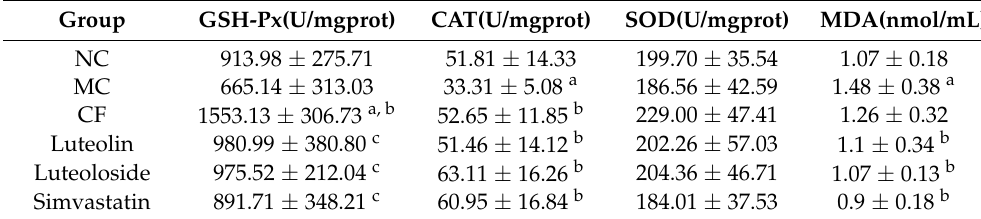
Table 9. GSH-Px, CAT, SOD, and MDA in the livers of each